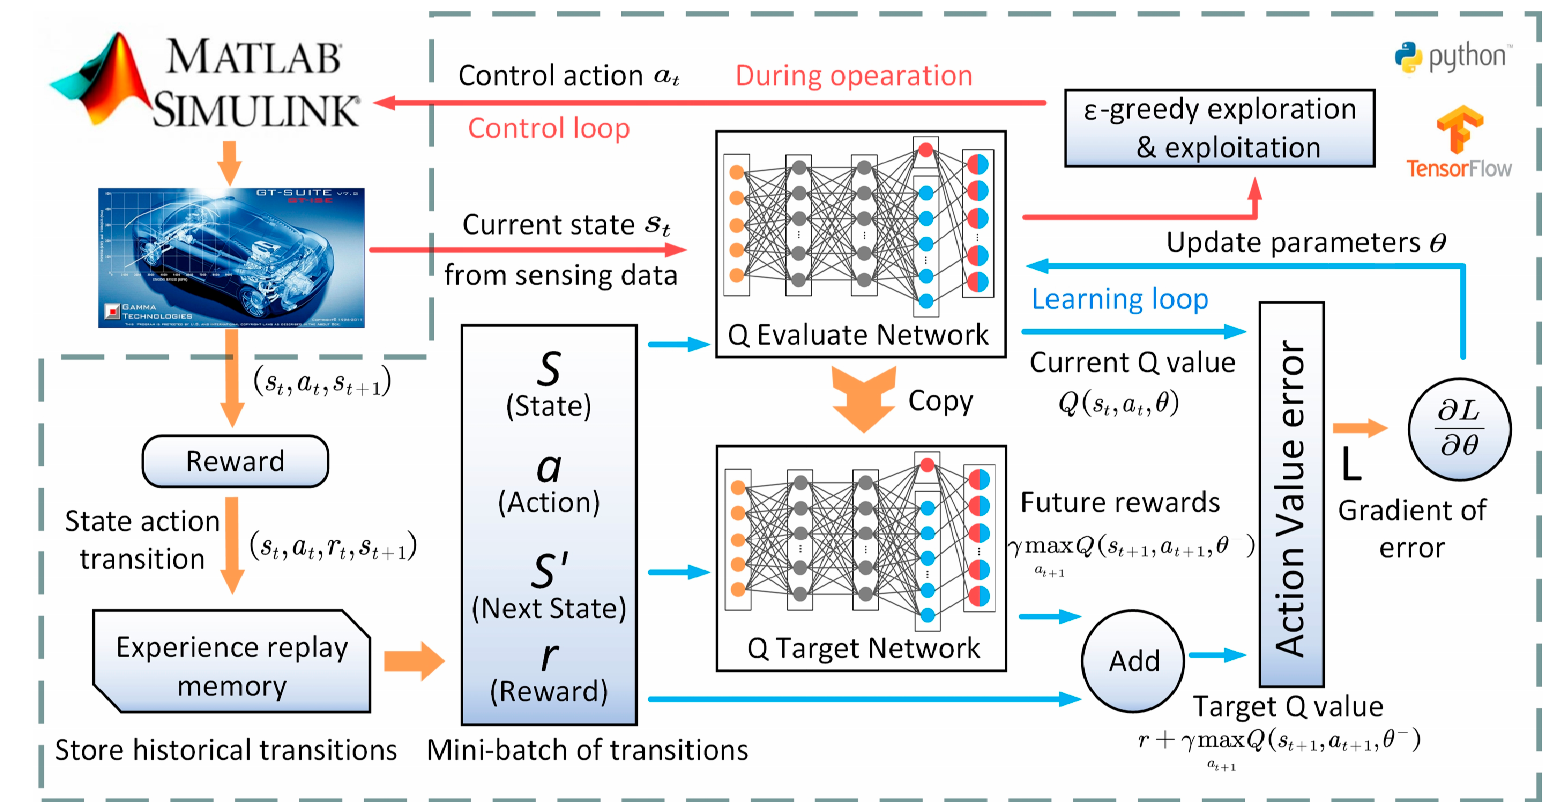
Figure 5. Dueling deep Q-network (DQN) implementation mechanism and the corresponding testing